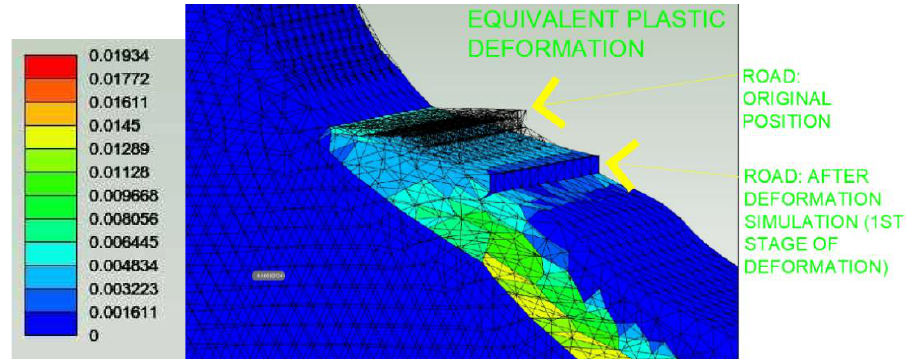
Figure 17. Equivalent plastic deformation obtained by FEM for a small section of the road that surrounds the Gjirokastra castle.